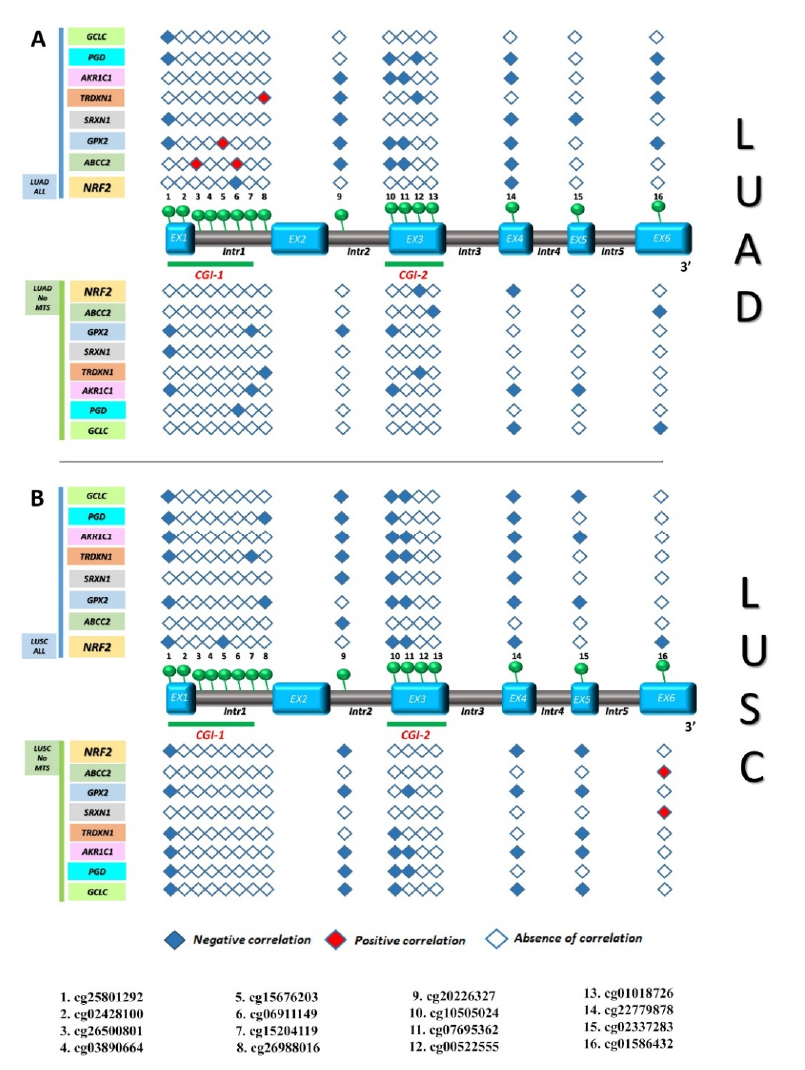
Figure 8. Correlation between KEAP1 CpGs methylation and transcript levels of NRF2 or its target genes in LUAD and LUSC cohorts. The KEAP1 gene structure is shown in the middle, including exons (sky blue boxes) and introns (brown boxes), as well as its two CpG islands: CGI-1 and CGI-2 (both underlined with green bars). A total of 16 CpG sites, marked with green circles, are indicated from 5 ′ to 3 ′ genomic localization (listed below). A filled rhombus, corresponding to a KEAP1 CpG site, depicts a significant inverse (blue square) or direct (red square) correlation ( R ≤ –0.1; p < 0.05) between methylation and transcript levels of NRF2 or its target genes in LUAD ( A ) and particularly in LUSC ( B ), in contrast to an empty rhombus indicating no significant correlation. Abbreviations: EX, exon; Intr, intron; CGI-1, CpG Island 1; CGI-2, CpG Island 2; LUSC, lung squamous cell carcinoma; LUAD, lung adenocarcinoma; No-mts, non-metastatic disease stages.